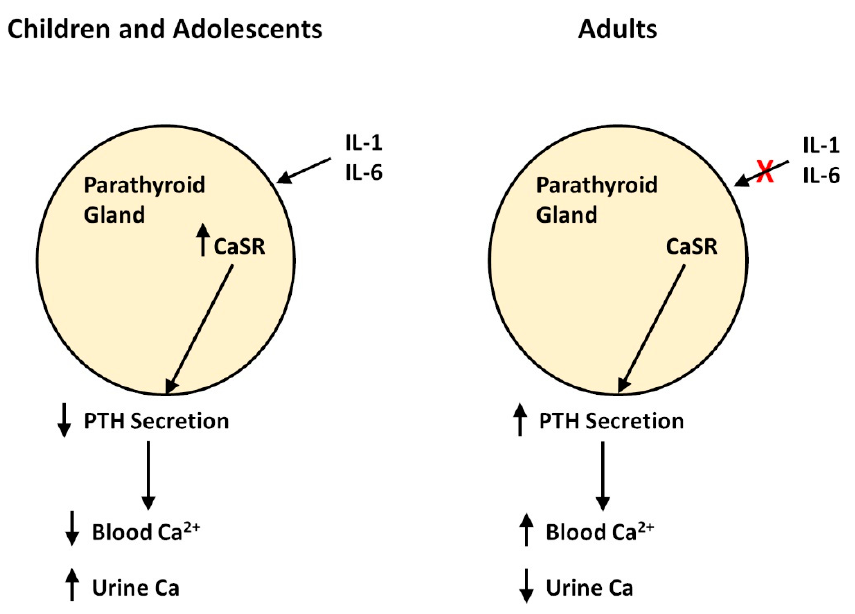
Figure 1. Parathyroid gland response to pro-inflammatory cytokines in children and adolescents and in adults following burn injury. In children and adolescents, the cytokines upregulate the membrane-bound G-protein coupled calcium-sensing receptor, causing a reduction in the amount of circulating calcium necessary to suppress parathyroid hormone secretion by the gland. The result is hypocalcemic hypoparathyroidism with increased urinary calcium excretion. In adults, this ability for the calcium ‐ sensing receptor to upregulate in response to inflammatory cytokines appears to be lost.